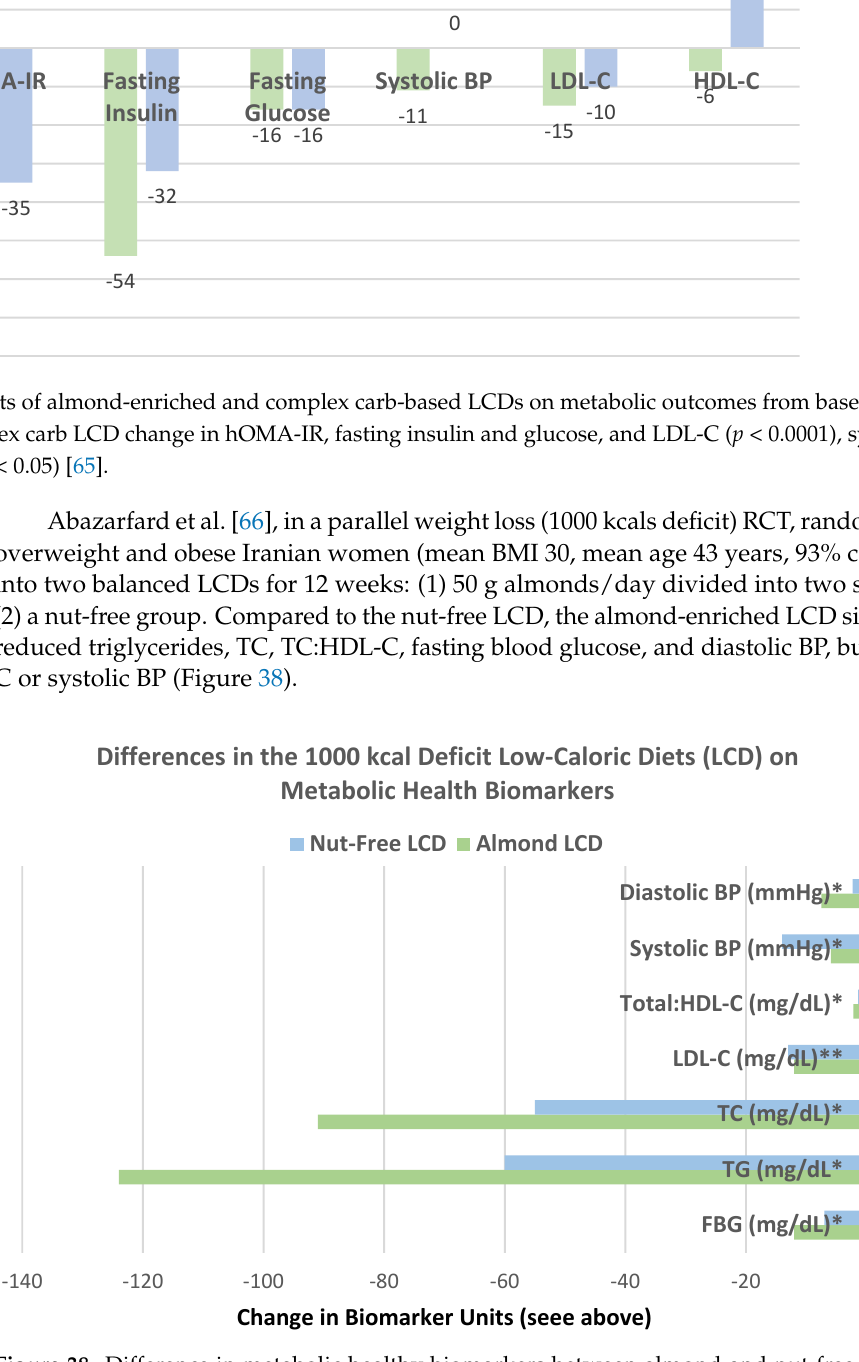
Figure 38. Difference in metabolic healthy biomarkers between almond and nut-free LCDs from baseline to 12 weeks (fasting blood glucose (FBG), triglycerides (TG), total cholesterol (TC), low- density lipoprotein cholesterol (LDL-C), and blood pressure (BP), * p ≤ 0.001 and ** p = 0.002)